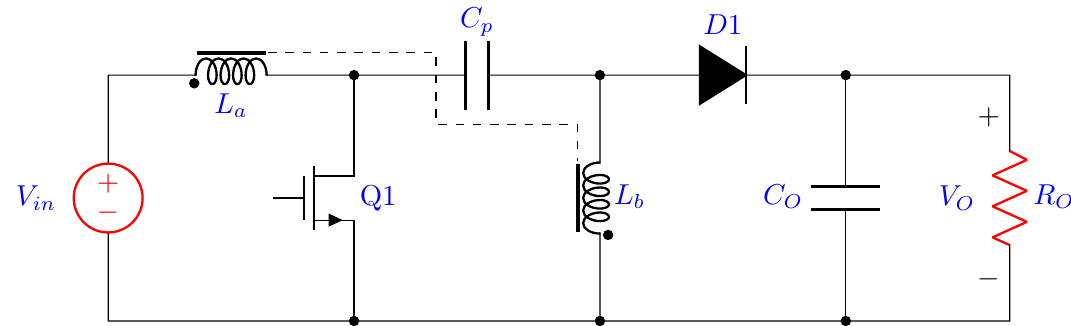
Figure 1. Single-Ended Primary-Inductor Converter (SEPIC) converter with coupled